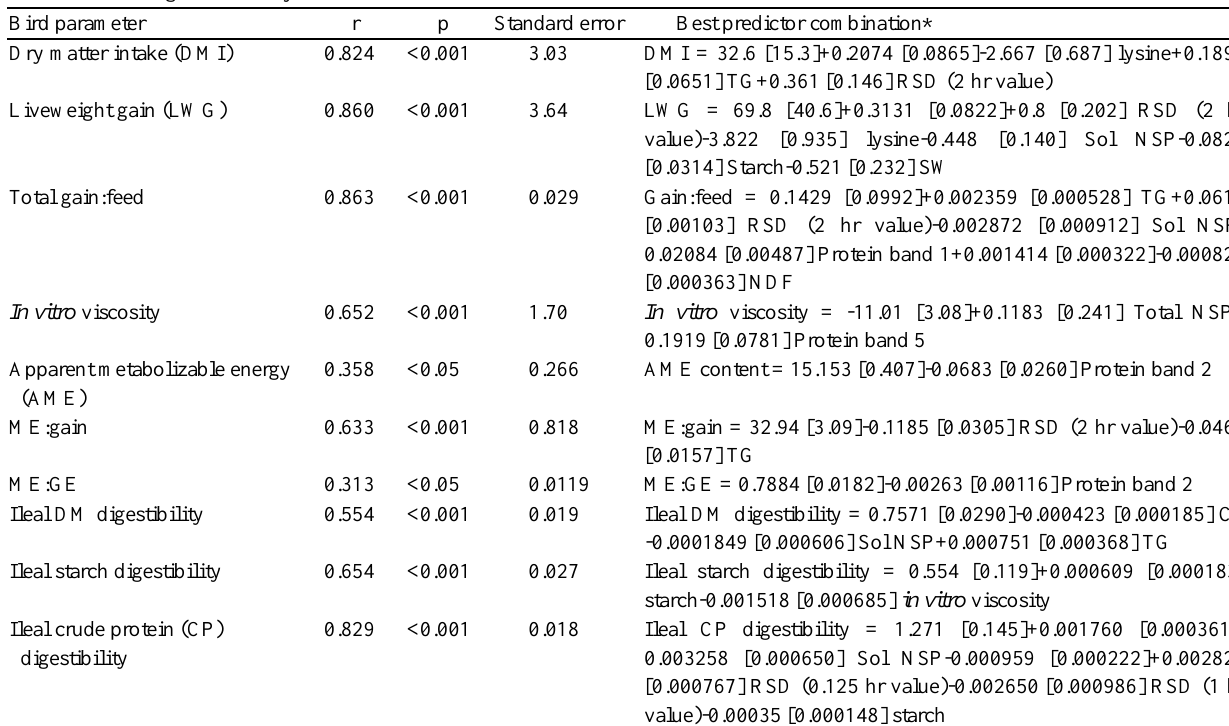
Table 6. Multi-regression